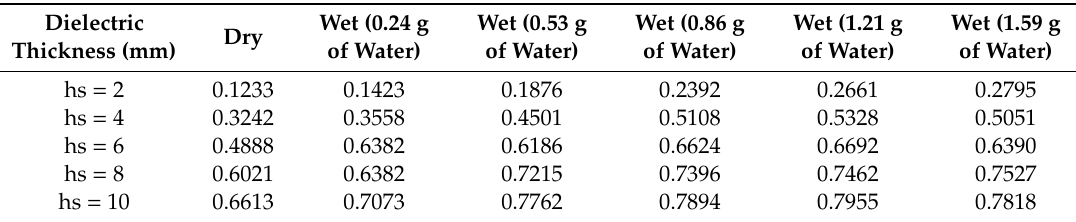
Table 7. E ffi ciency of the simulated radiation pattern of antenna performance for the dry and wet conditions at 2.45